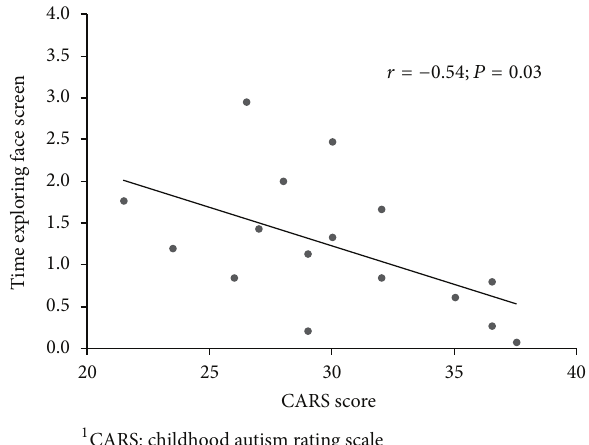
Figure4:CorrelationbetweentimeexploringfacescreenandCARS score 1 in autism